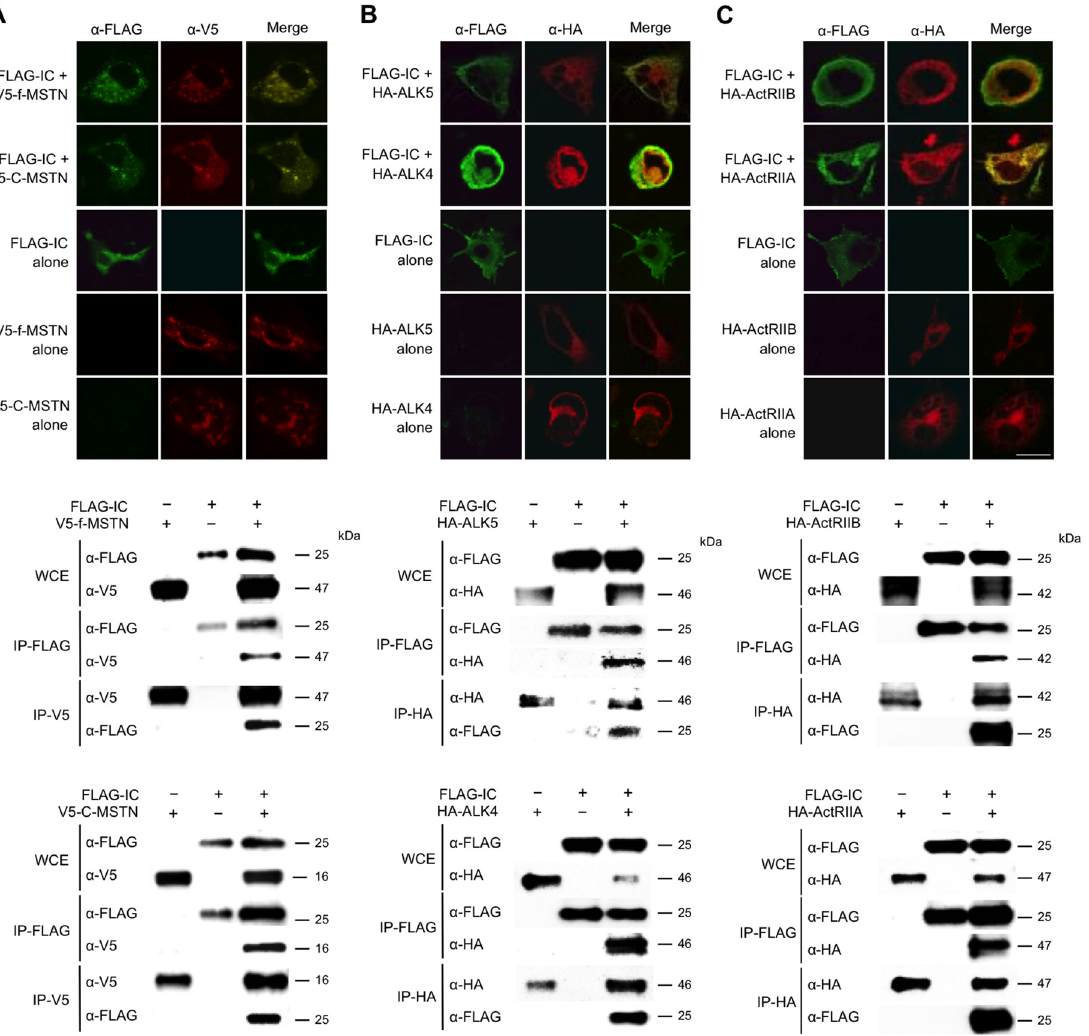
Fig 3. Interaction of the inhibitory core of myostatin with its ligand and receptors. Co-localization ( Upper ) and co-immunoprecipitation ( Lower ) of the inhibitory core (IC) of the myostatin prodomain and its ligand ( A ), its type I receptors (ALK4 and ALK5, B ), and its type II receptors (ActRIIA and ActRIIB, C ) in COS-7 embryonic kidney cells expressing FLAG-tagged IC and V5- or HA-tagged ligand or receptors. Scale bar, 20 μ m. Whole cell extracts (WCE) were immunoprecipitated with anti-FLAG, anti-V5, or anti-HA agarose and then immunoblotted using anti-FLAG, anti-V5, or anti-HA antibodies,